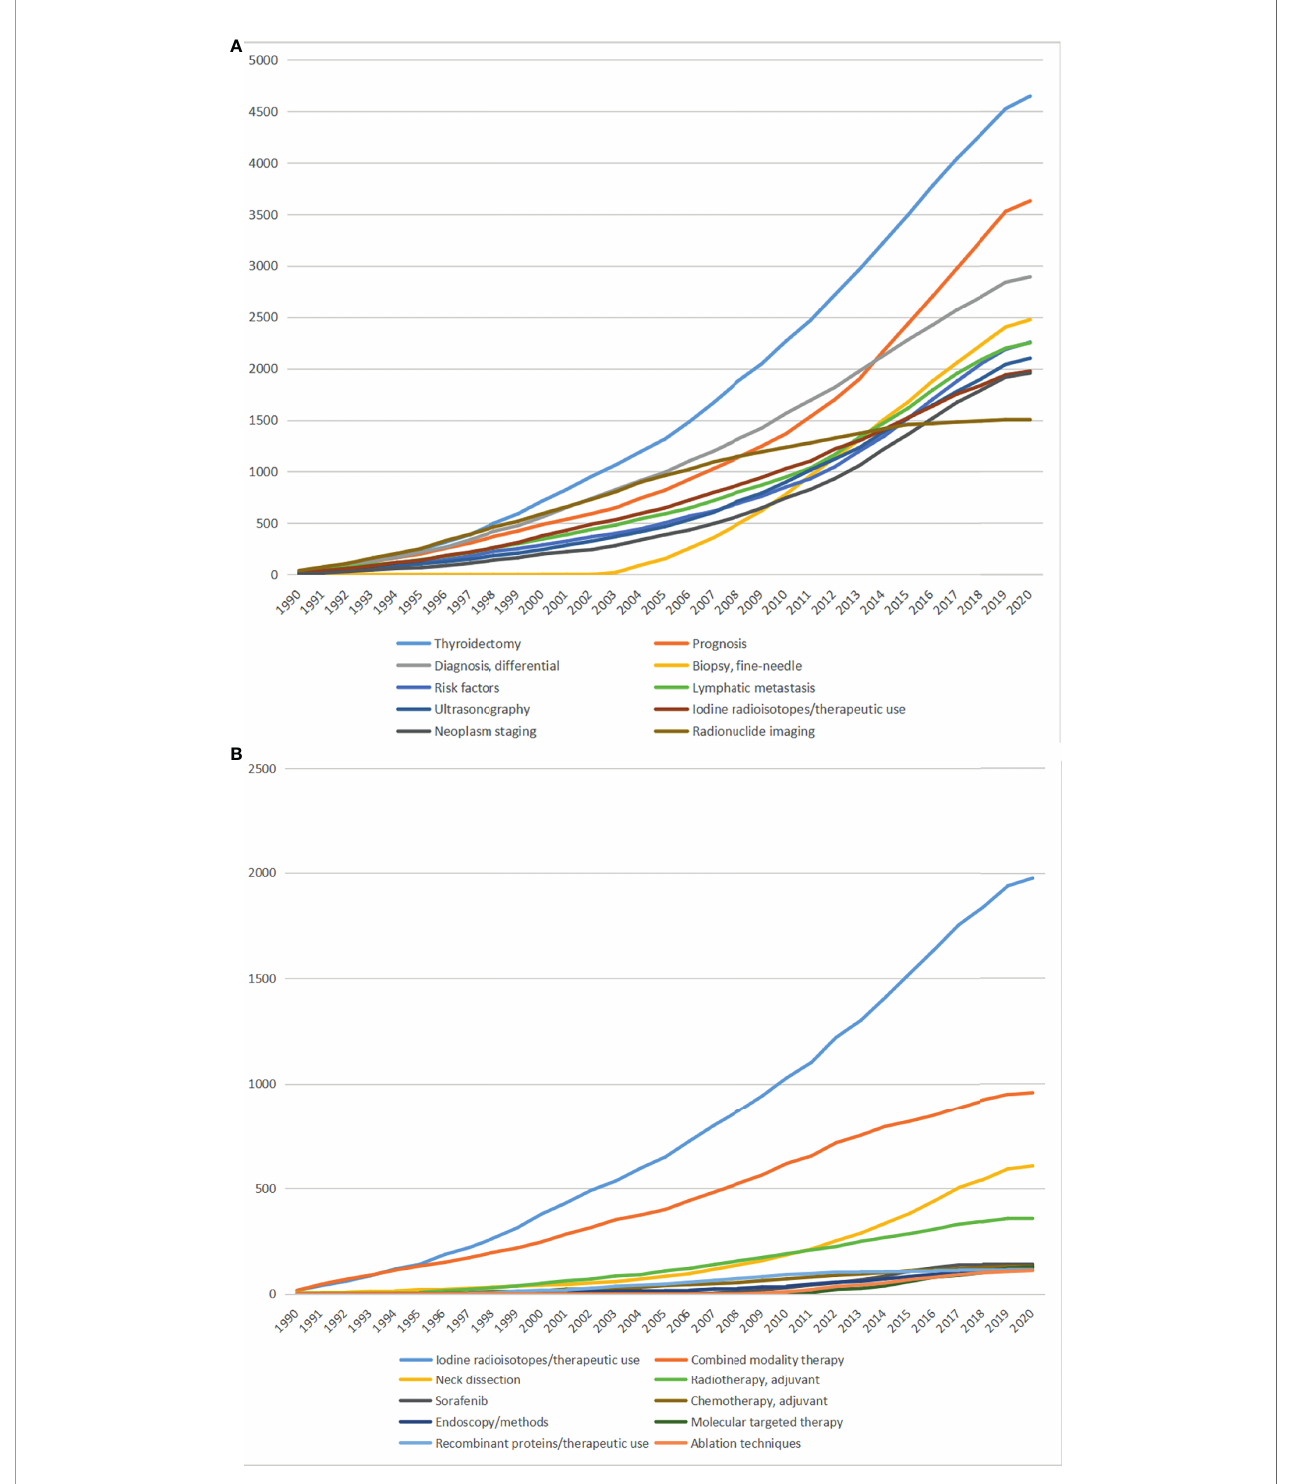
FIGURE 4 | (A) Top 10 MeSH terms and accumulative occurrences during the past three decades; (B) Top 10 MeSH terms concerning treatments of thyroid cancer and accumulative occurrences during the past three